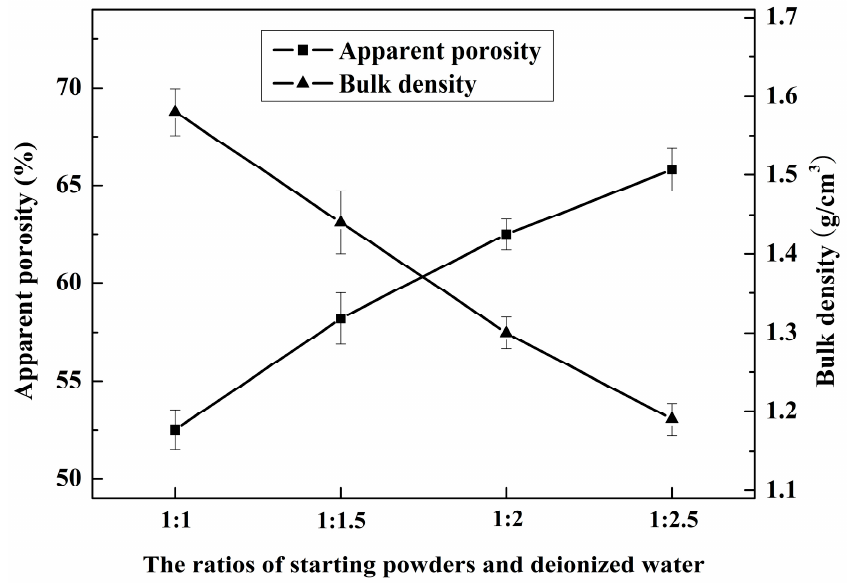
Figure 4. The apparent porosity and bulk density of the samples with different ratios of starting powders and deionized water sintered at 1600 °C for 4 h.